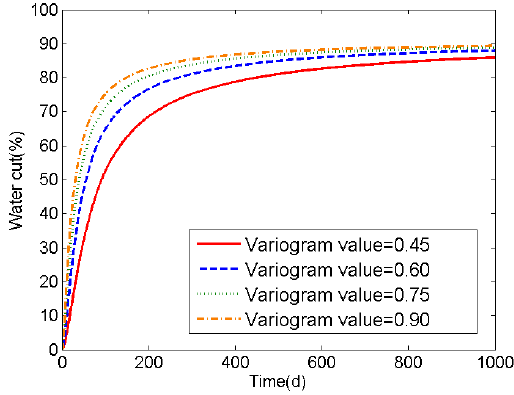
Figure 6. Water cuts with different variogram values.